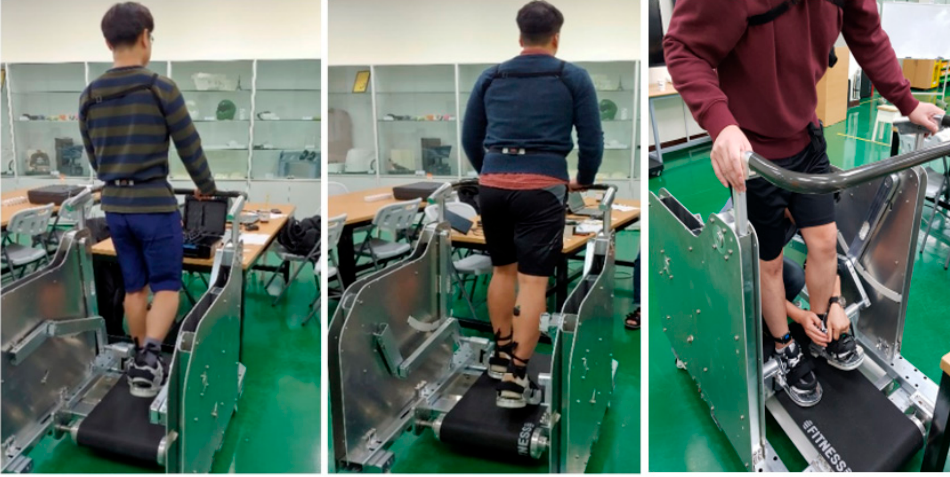
Figure 3. Scene of the experiment.